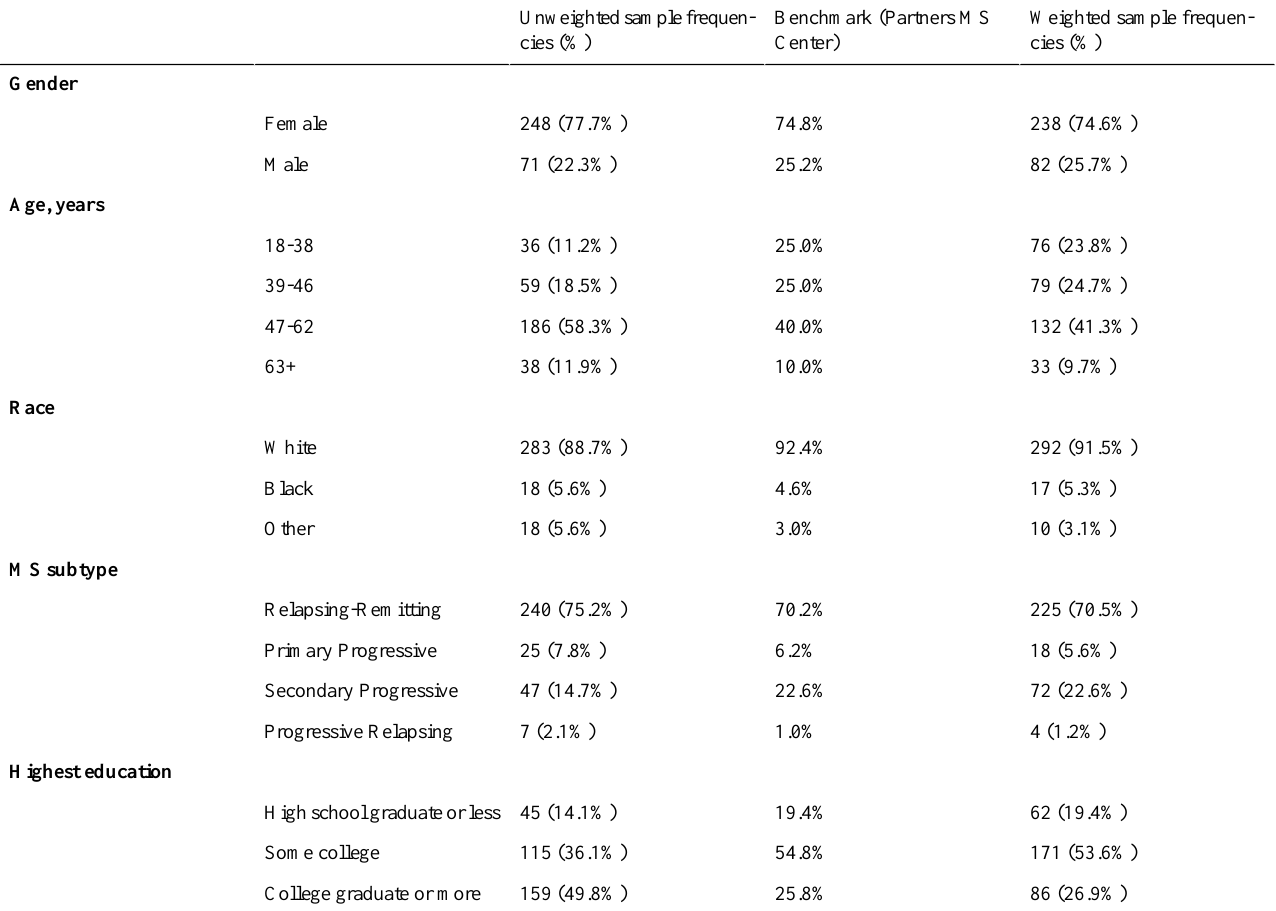
Table 3. Sample demographics before and after weighting (n=319). a